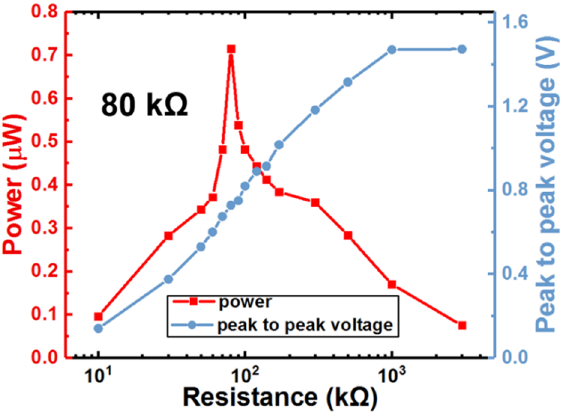
Figure 7. Test results of optimal loading resistance for the strong harvest.